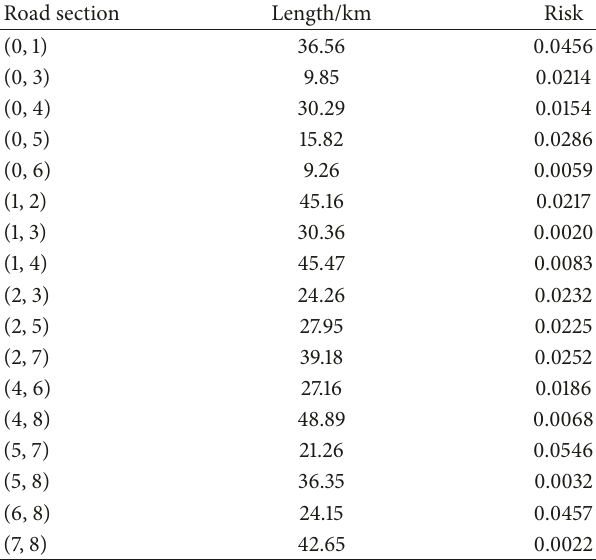
Table 1: Lengths of each road section and risks of vehicles traveling in each road